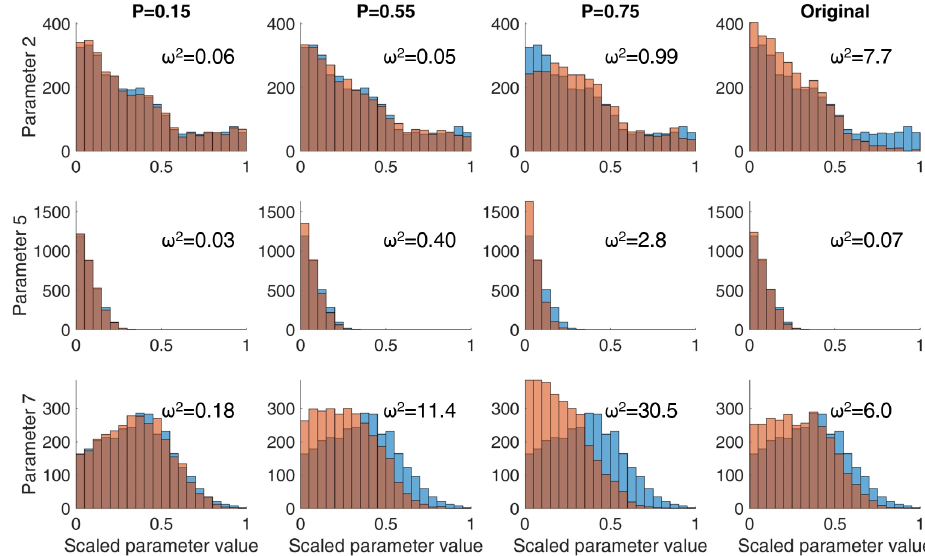
Figure 4. Histograms of the three parameters with the most complicated posterior marginal distributions. Each row shows a parameter and each column a sampling scheme. Blue bars: histograms from pure Monte Carlo sampling (i.e., true distribution); brown bars: sampling schemes with preselection; numbers: Cramér–von Mises metric ω 2 for the distance between the two distributions, here shown multiplied by 1000 for increased readability.